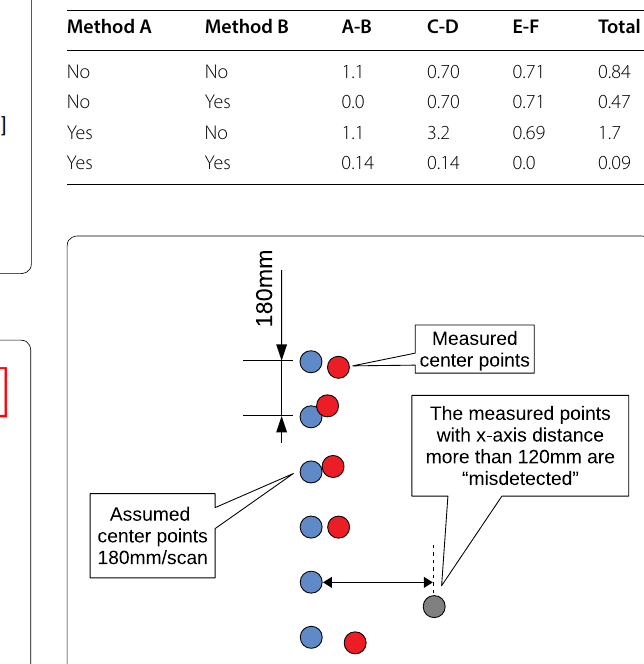
Fig. 17 Trajectory of the center points of the target person Fig. 18 Decision of misdetection of a measured person’s